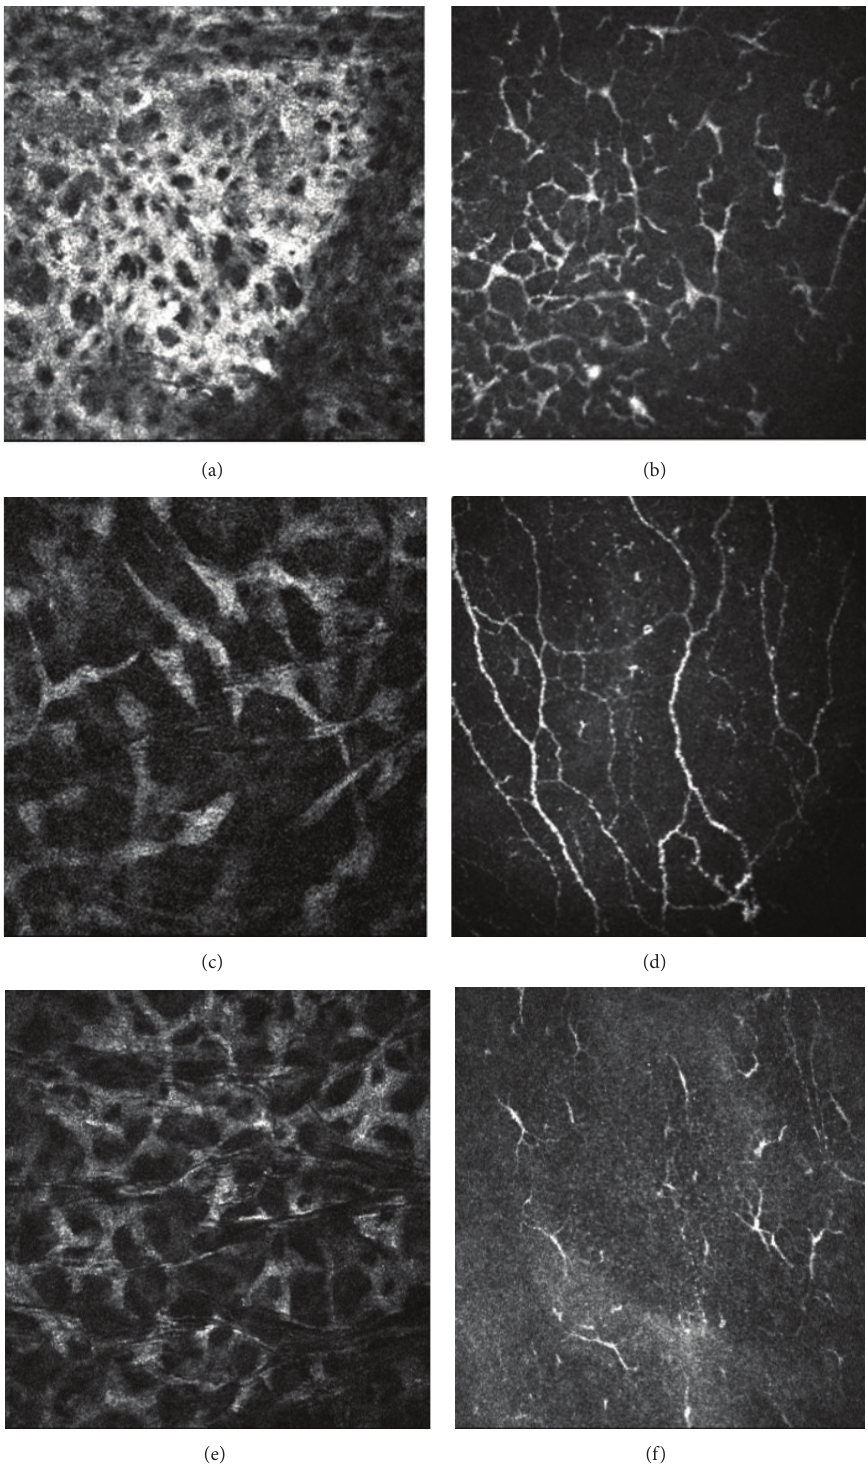
Figure 2: IVCM images of ocular surface inflammation in dry eye. (a) Numerous activated keratocytes in corneal anterior stroma. (b) High number of dendritic cells in corneal subepithelium. (c–f) Reduction of inflammation signs in corneal stroma and subepithelial layer, more evident after 90 days of Optive treatment (c-d) with respect to Hylogel group